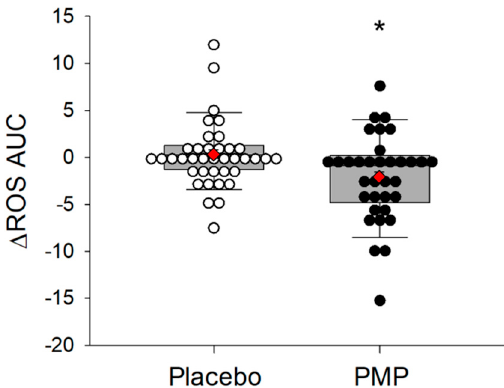
Figure 3. Box and scatter plot of the change in plasma ROS AUC after eight-week supplementation.